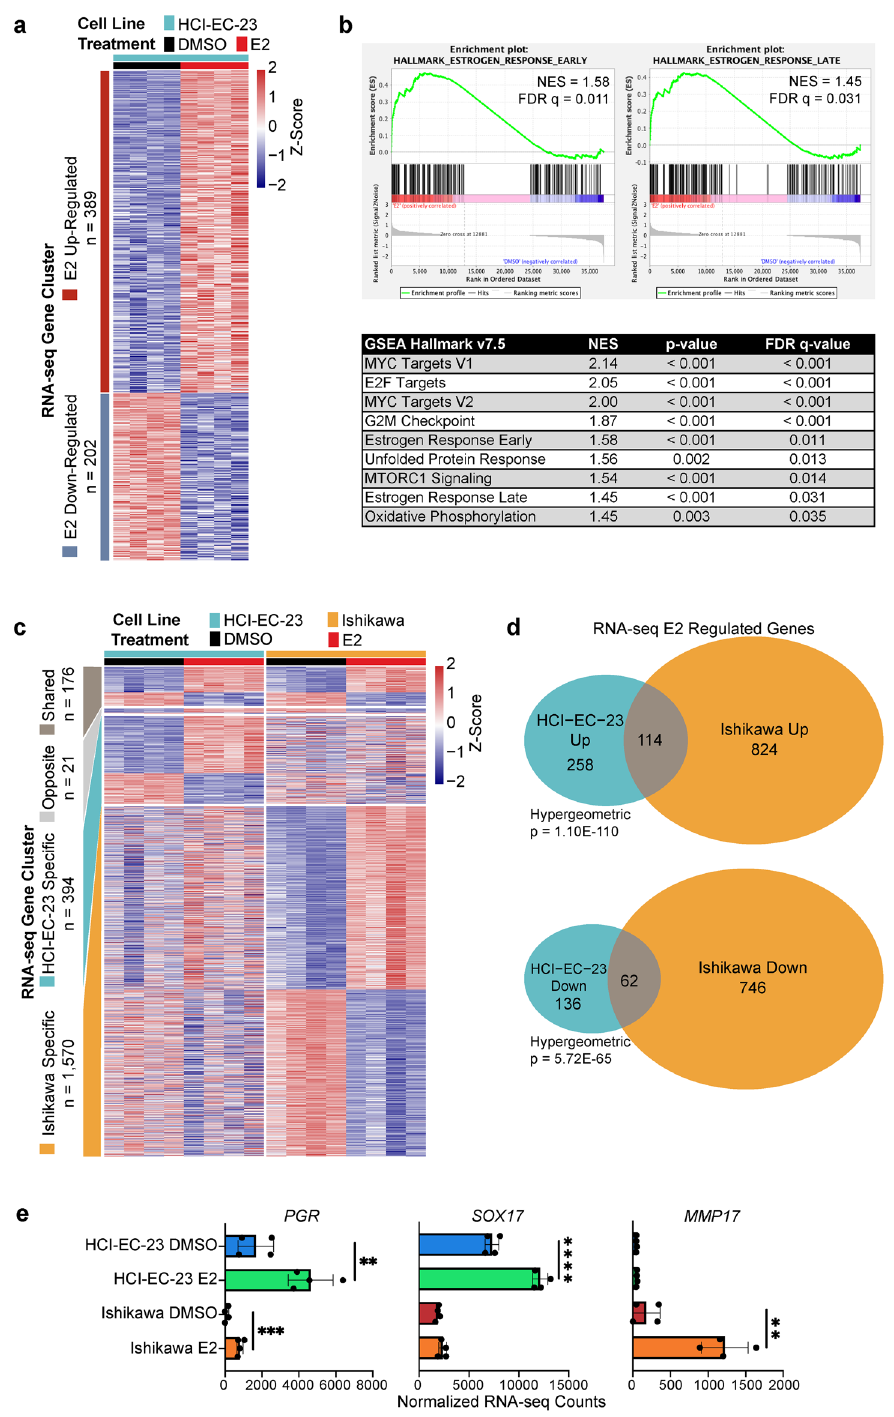
Figure 4. HCI-EC-23 has a transcriptomic response to estrogens that is similar but distinct to Ishikawa. (a) A heatmap showing relative expression of genes up- and down- regulated in response to E2 treatment is shown for HCI-EC-23. Each row represents a gene and is annotated by the gene clusters to the left. Samples and treatments are shown by column as indicated in the legend above the heatmap. (b) Gene set enrichment analysis (GSEA) plots are shown for the early (left) and late (right) hallmark estrogen response genes. A table of all other significantly enriched hallmark GSEA sets is shown below. NES is the normalized enrichment score. FDR q-value is the false discovery rate. (c) A heatmap shows the relative expression of genes up- and down- regulated in response to E2 treatment in HCI-EC-23 compared to Ishikawa cells. Each row represents a gene and is annotated by the gene clusters to the left. Gene clusters identified are shared genes, genes regulated in opposite directions between the two lines, HCI-EC-23 specific, and Ishikawa specific. Samples and treatments are shown by column as indicated in the legend above the heatmap. (d) A Venn diagram showing the overlap between E2 up- (top) and down- (bottom) regulated genes in HCI-EC-23 and Ishikawa cell lines. Shown is the hypergeometric p-value for significance of overlap. (e) Bar plots are shown for example E2 regulated genes in HCI-EC-23 and Ishikawa. Points represent individual replicates. Error bars represent standard